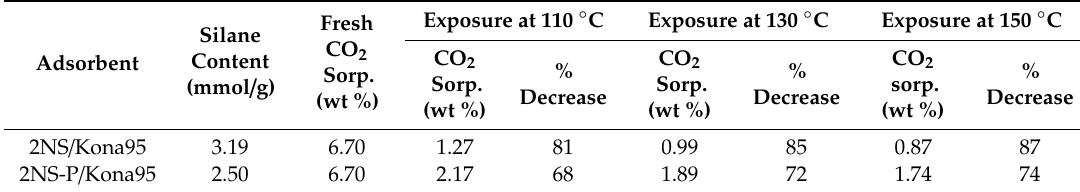
Table 2. Percent decrease in the capacity of the adsorbents exposed to 100% CO 2 at 110, 130, and 150 °C for 24 h in TGA.